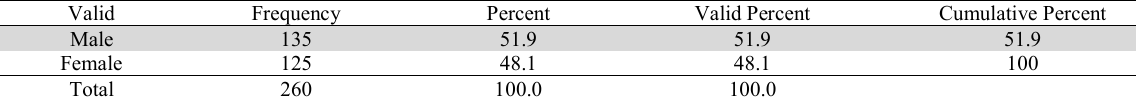
Descriptive statistics of Gender of the Respondents